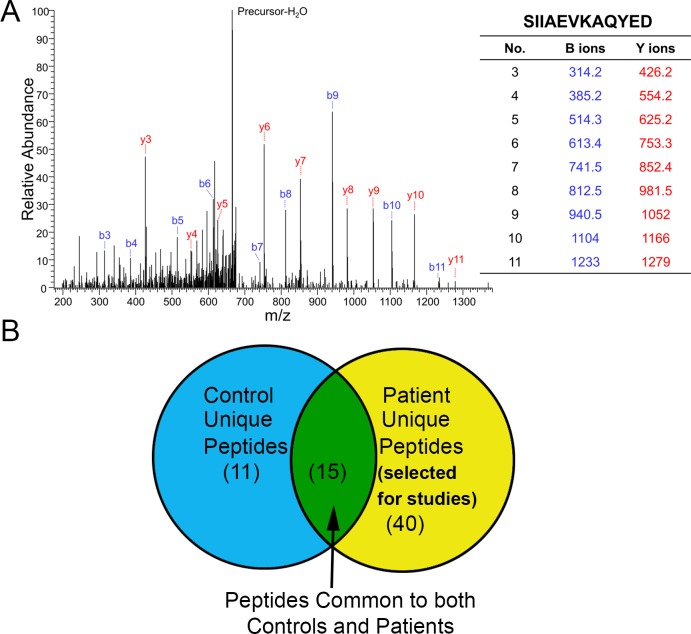
Peptide identification and selection.(A) Representative MS/MS spectrum of immuno-precipitated peptide, identified as Keratin, type II cytoskeletal 8. (B) Venn diagram depicting selection method for patient-unique peptides used in the study. Parenthesis indicates number of peptides detected.